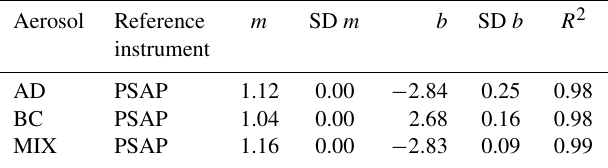
Table 9. Linear-regression parameters obtained by fitting 10s aver- aged data including the slope ( M ), standard deviation of the slope (SD m ), intercept ( B ), standard deviation of intercept (SD b ) and linear-regression coefficient ( R 2 ) for the comparison of the CAPS PM SSA and the PSAP